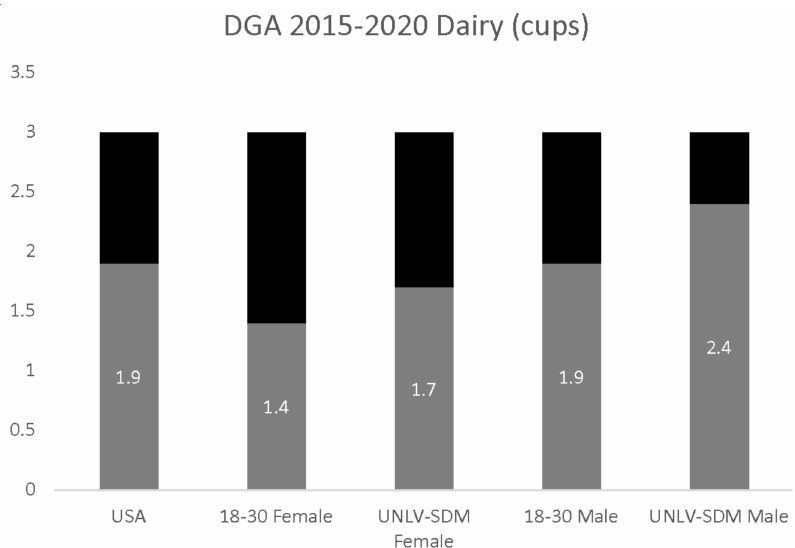
Figure 3. DGA dairy consumption analysis. UNLV-SDM dental student females consumed signifi- cantly less than males, p = 0.0014—although this was higher than observed among 18 to 30-year-olds, p = 0.0388, but still did not meet the DGA recommendations.